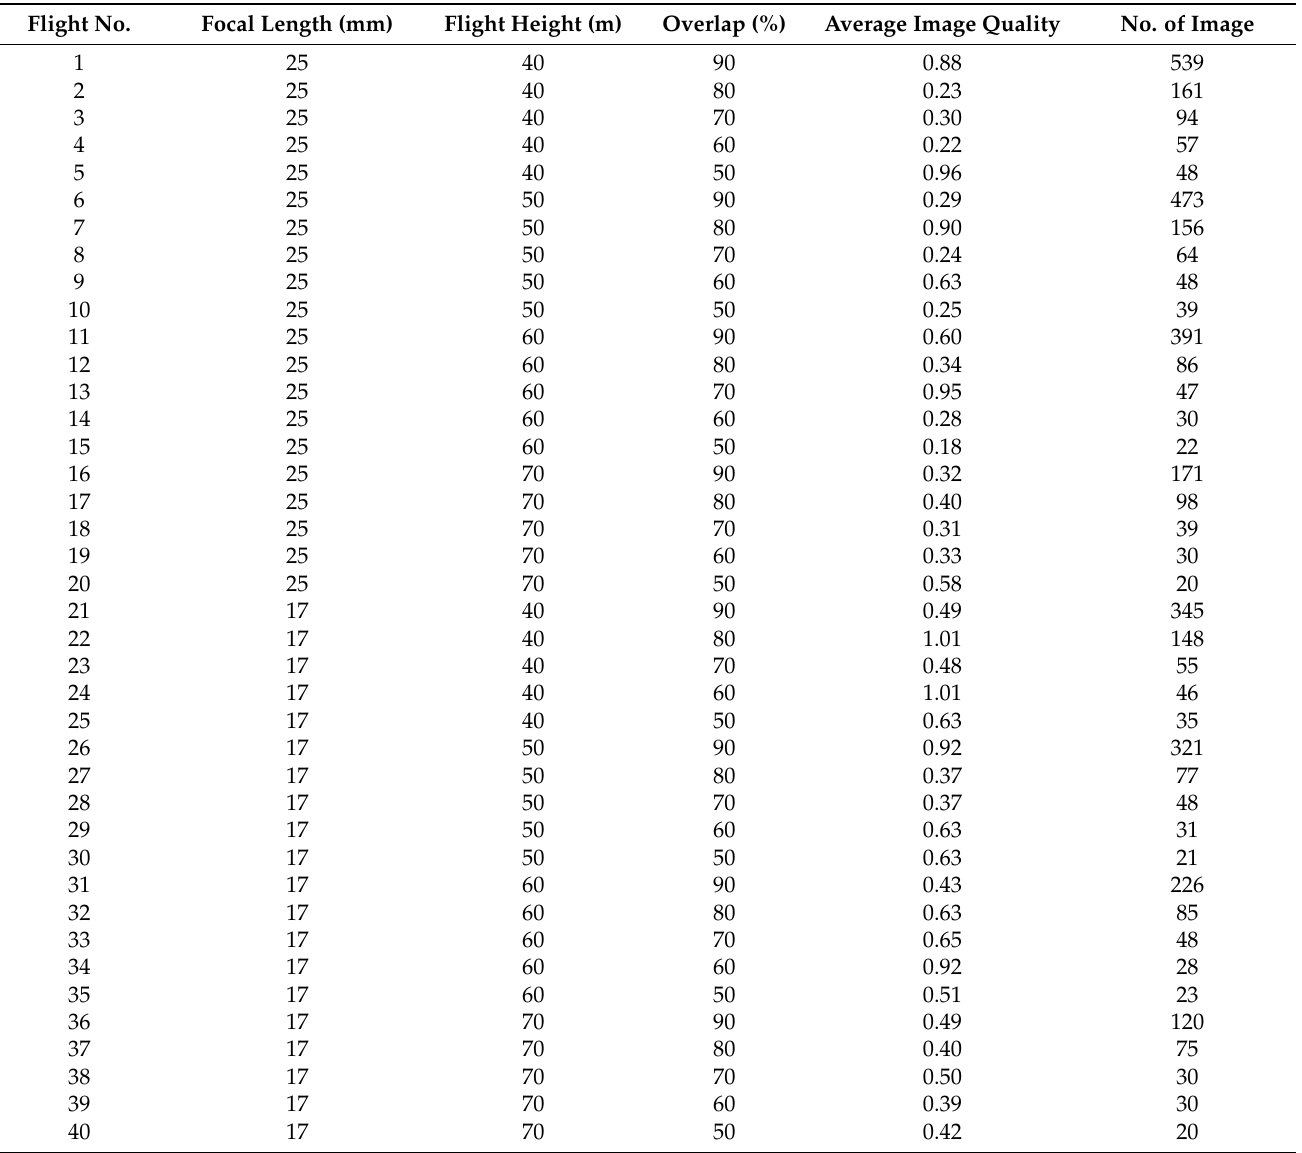
Table 2. Detailed Flight Mission